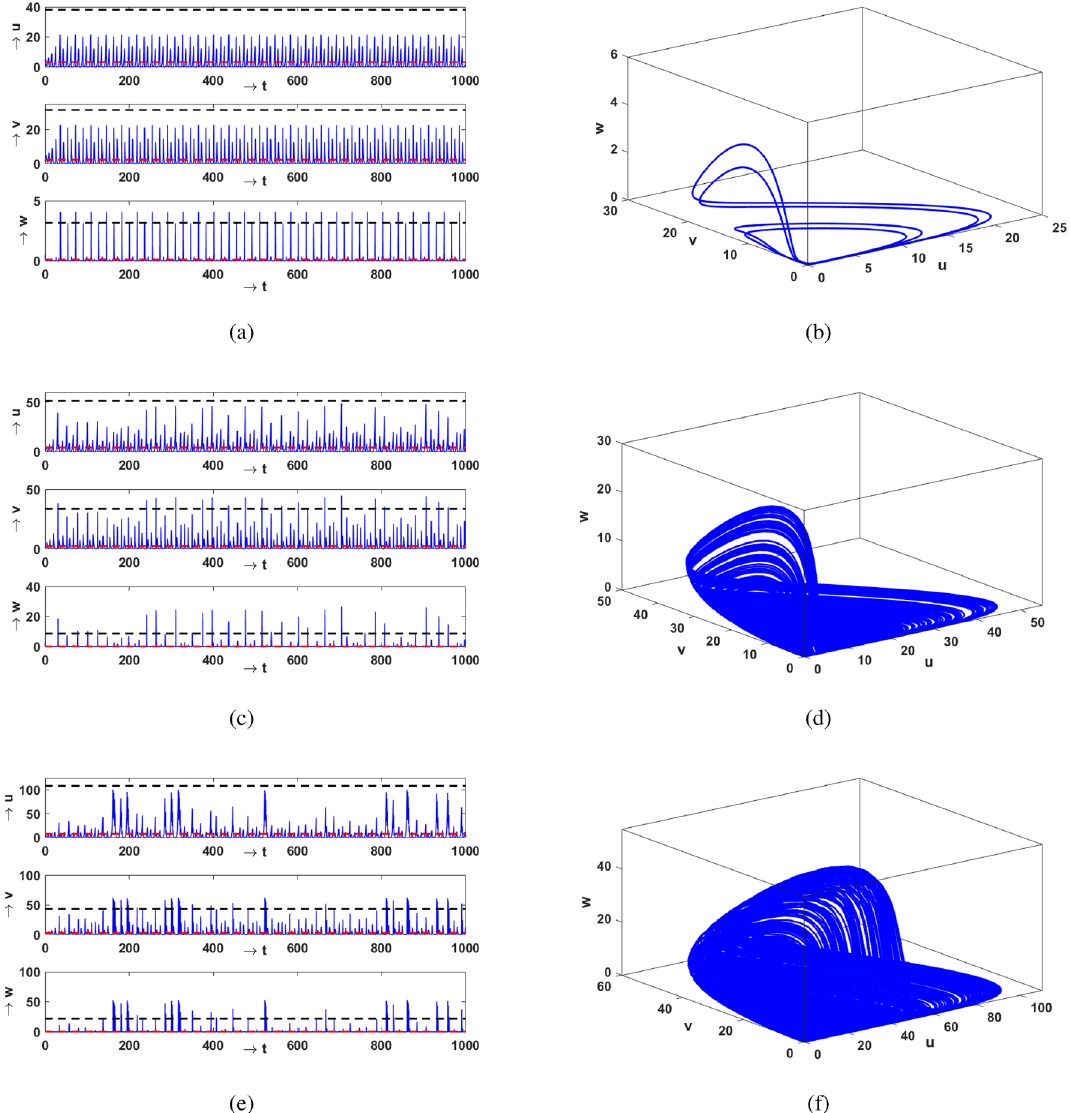
Figure 2. Left panels display the time series for the vegetation ( u ), prey ( v ) and predator ( w ) populations in the system given by Eq. (1), and the right panels display the corresponding phase space attractor. The Allee effect parameter is θ = 0 ( a , b ), θ = 0.01776 ( c , d ), and θ = 0.02475 ( e , f ). The red dashed line shows the mean µ , and the black dashed line represents the threshold level of 7 standard deviations above the mean (i.e. µ + 7 σ